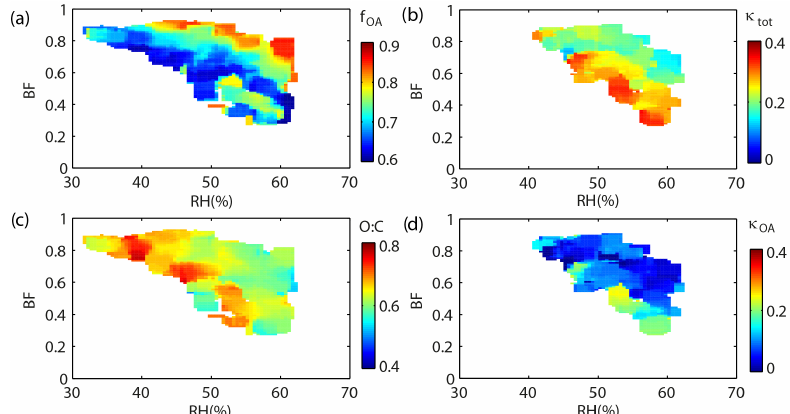
Figure 4. Comparison between BF, impactor RH and particle properties for ambient-only data; (a) (RH, BF) data colored with fraction of organics derived from AMS analysis, (b) (RH, BF) data colored with hygroscopicity- κ derived from HTDMA results, (c) (RH, BF) data colored with O:C (Canagaratna et al., 2015) derived from AMS analysis and (d) (RH, BF) data colored with hygroscopicity κ of the OA fraction of the particles derived from HTDMA and AMS results. Data are filtered by f OA ≥ 0 . 6 and precipitation <1mmh − 1 .